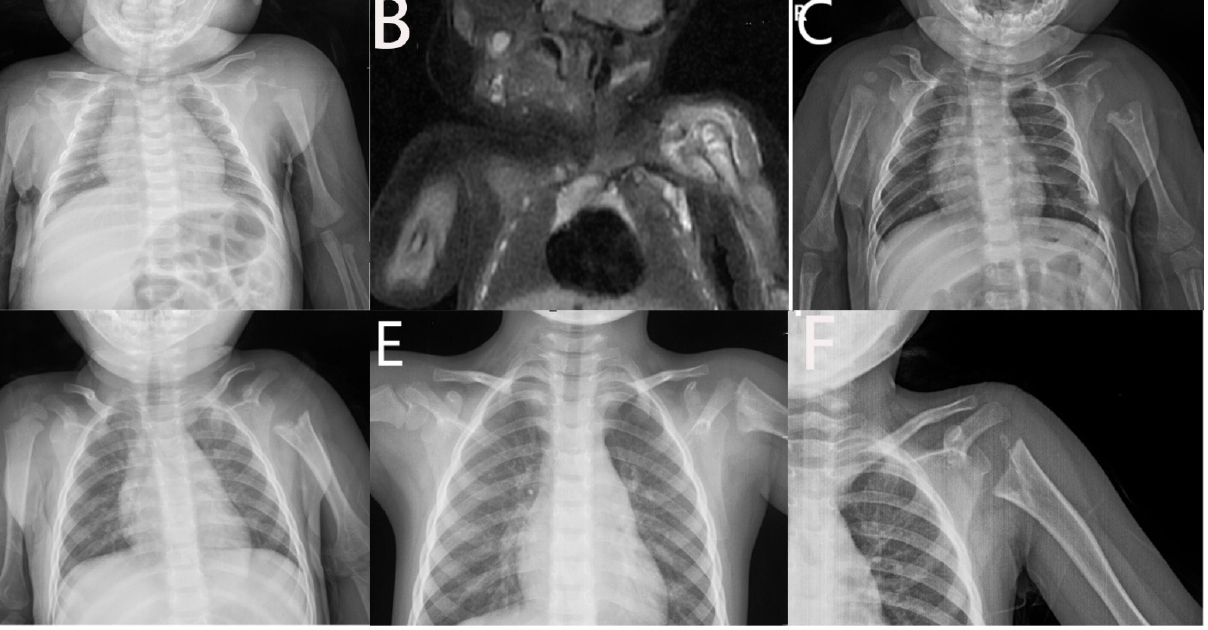
Figure 3. Humeral epiphyseal osteomyelitis and septic arthritis of shoulder joint of 12-day girl. ( A ). AP view of shoulder joint. ( B ). MR image of shoulder joint. ( C ). Intraoperative image of decompres- sion and drainage. ( D ). AP view of shoulder joint at 1st month follow-up. ( E ). AP view of shoulder joint at 3rd month follow-up. ( F ). AP view of shoulder joint at 12th month follow-up.